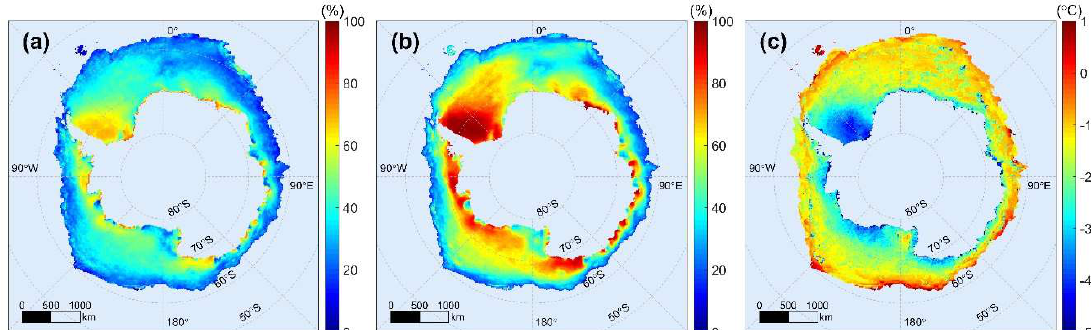
Figure 10. Spatial distribution of the pixel average of SAL (%) ( a ), SIC (%) ( b ), and SST ( ◦ C) ( c ) during summer.